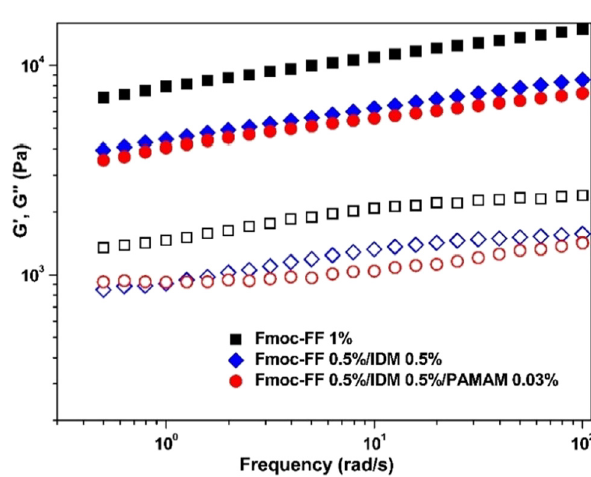
Figure 9: Oscillatory frequency sweeps of IDM - loaded Fmoc - FF – PAMAM dendrimer hydrogels: closed symbols denote G ′ and open symbols denote G ″